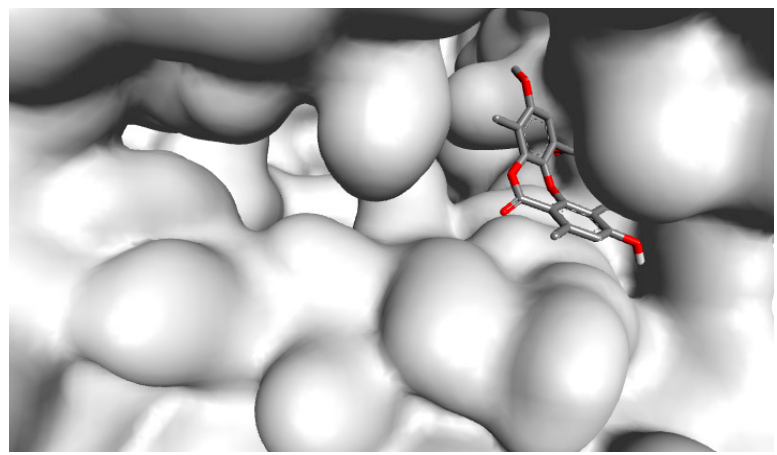
Figure 1. Molecular surface illustration of HSV-1 DNA polymerase, where psoromic acid efficiently binds to the active site of the enzyme. Molecules 2019 , 24 , x